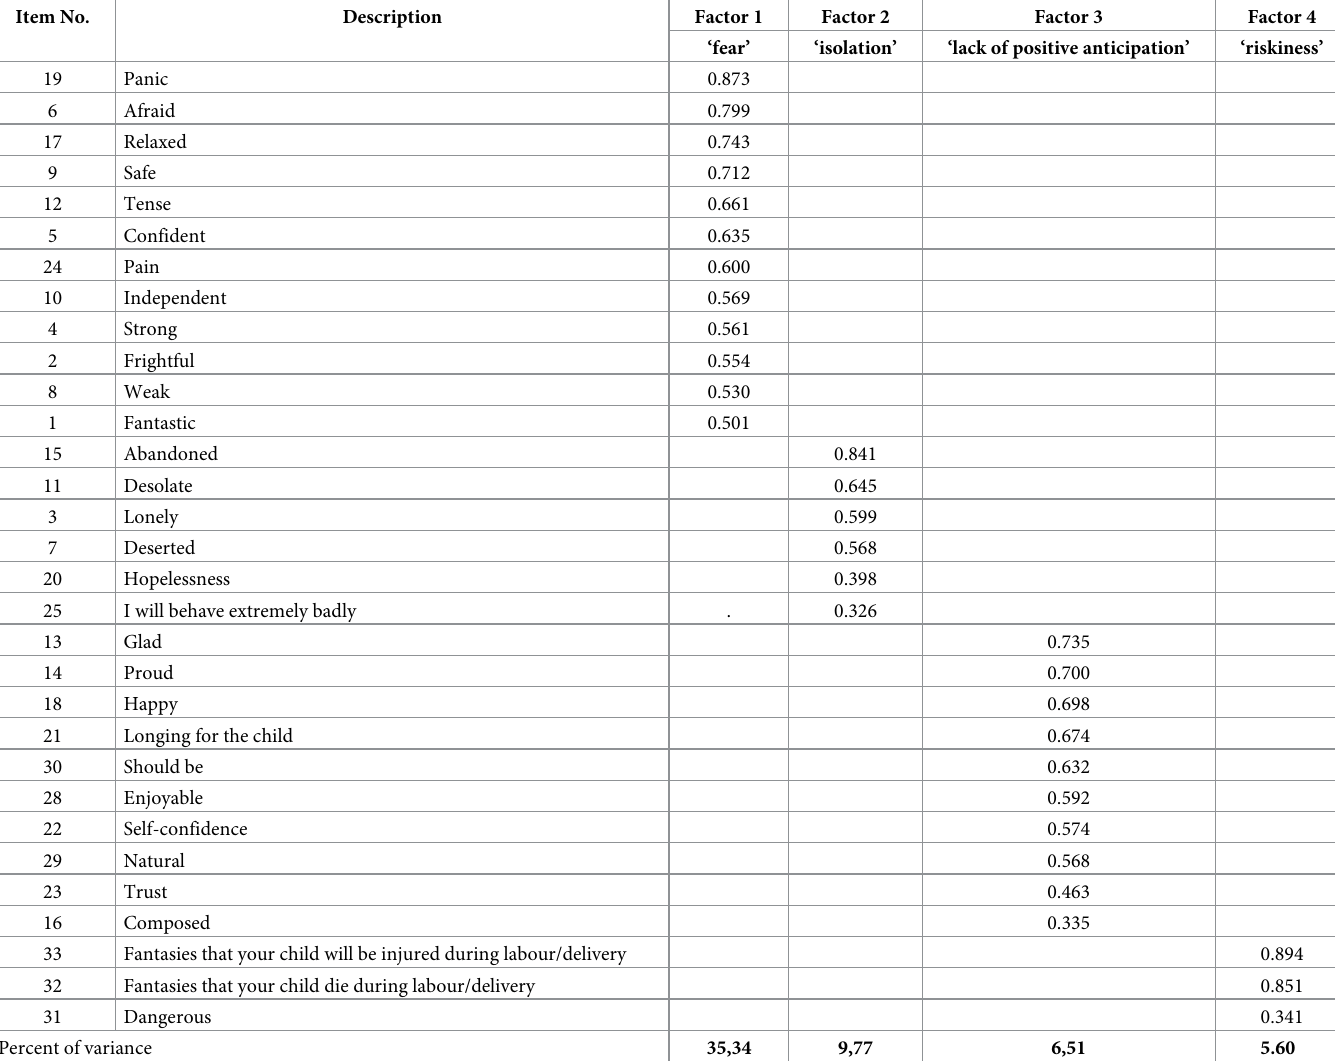
Table 6. Loading matrix related to the exploratory factor analysis solution.